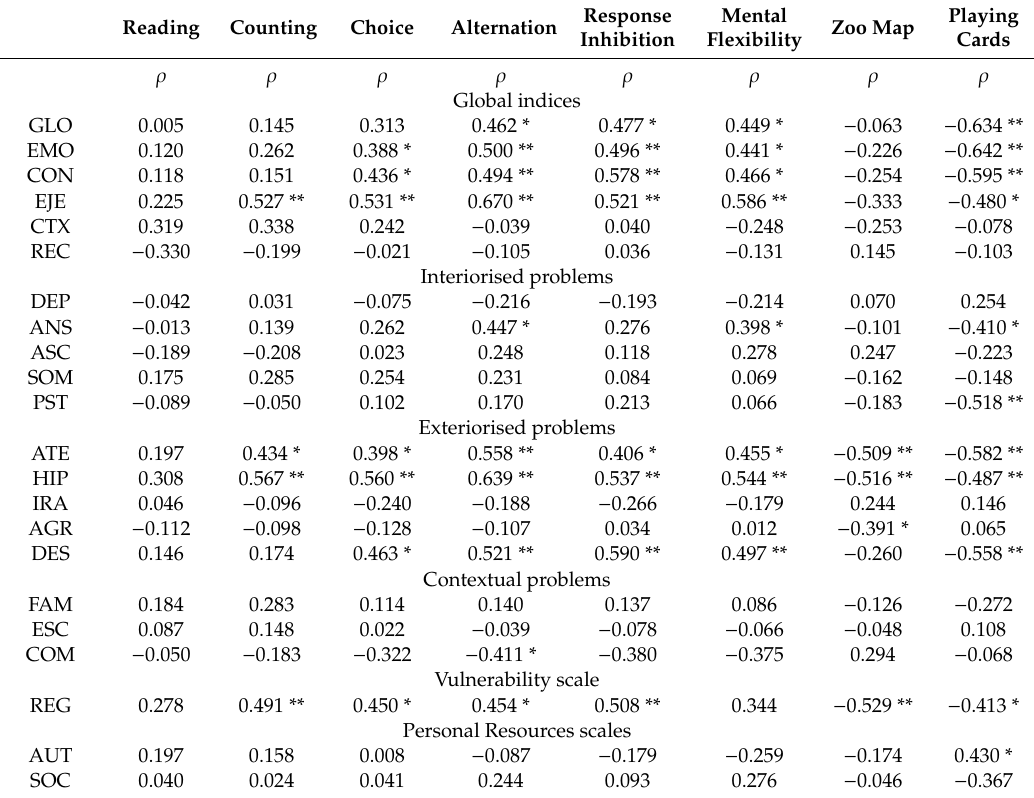
Table 3. Correlation analysis between the children’s emotional and behavioural problems and their executive